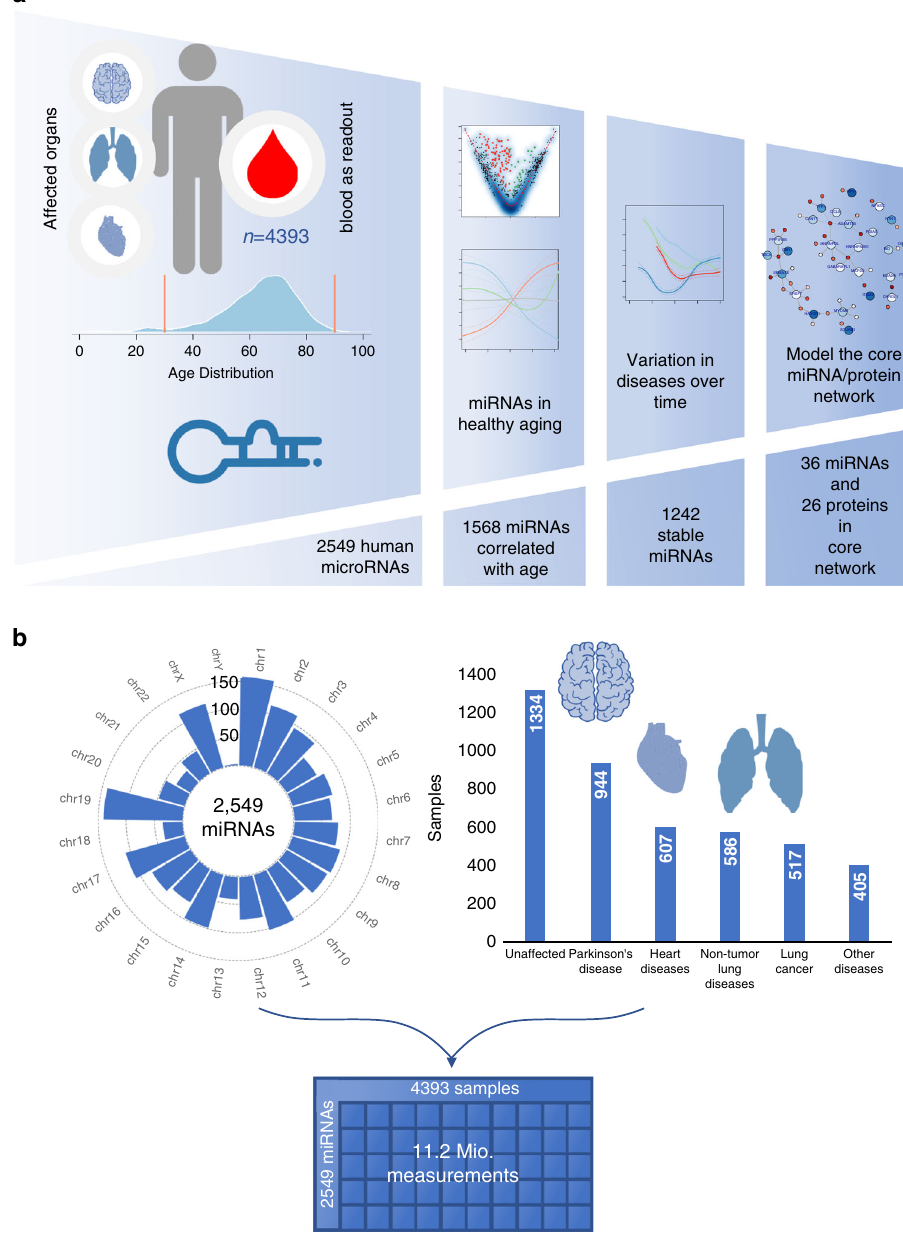
Fig. 1 Study characteristics. a Study set up and analysis work fl ow from high-throughput data to a speci fi c aging network. The cohort consist of 4393 samples of which the age distribution is provided. For the 4393 samples genome wide miRNA screening using microarrays has been performed. The fi rst analysis describes 1568 miRNAs that are correlated to age in healthy individuals. In the second step we identi fi ed disease speci fi c miRNA changes with aging and fi nally de fi ne a set of 1242 miRNAs that are not affected by diseases. Finally, to model regulatory cascades in healthy aging we related the miRNA data to plasma proteins and identi fi ed a core aging network. b The circular plot shows the genome wide nature of our miRNA approach, all miRNAs from miRBase V21 were included in the experimental analysis. We measured 4393 samples for the abundance of these miRNAs, resulting in a 2549 times 4393 data table containing 11.2 million miRNA measurements that correspond to over 2 × 10 8 spots on the